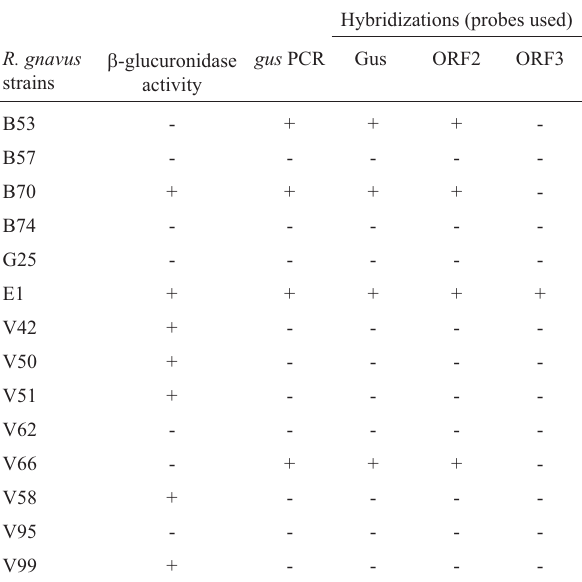
Table 2 - Summary of β -glucuronidase activity, PCR amplifications and hybridizations for each strain. All strains are Ruminococcus gnavus strains, listed in Table1.